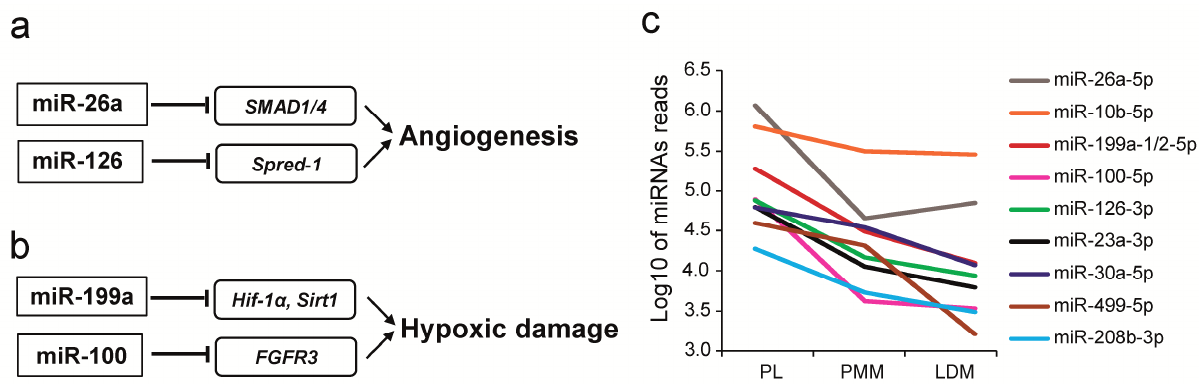
Figure 5. Energy metabolism-related miRNAs enriched in PL. miRNAs involved in ( a ) angiogenesis and ( b ) reducing hypoxic damage; ( c ) Abundance of energy metabolism-related